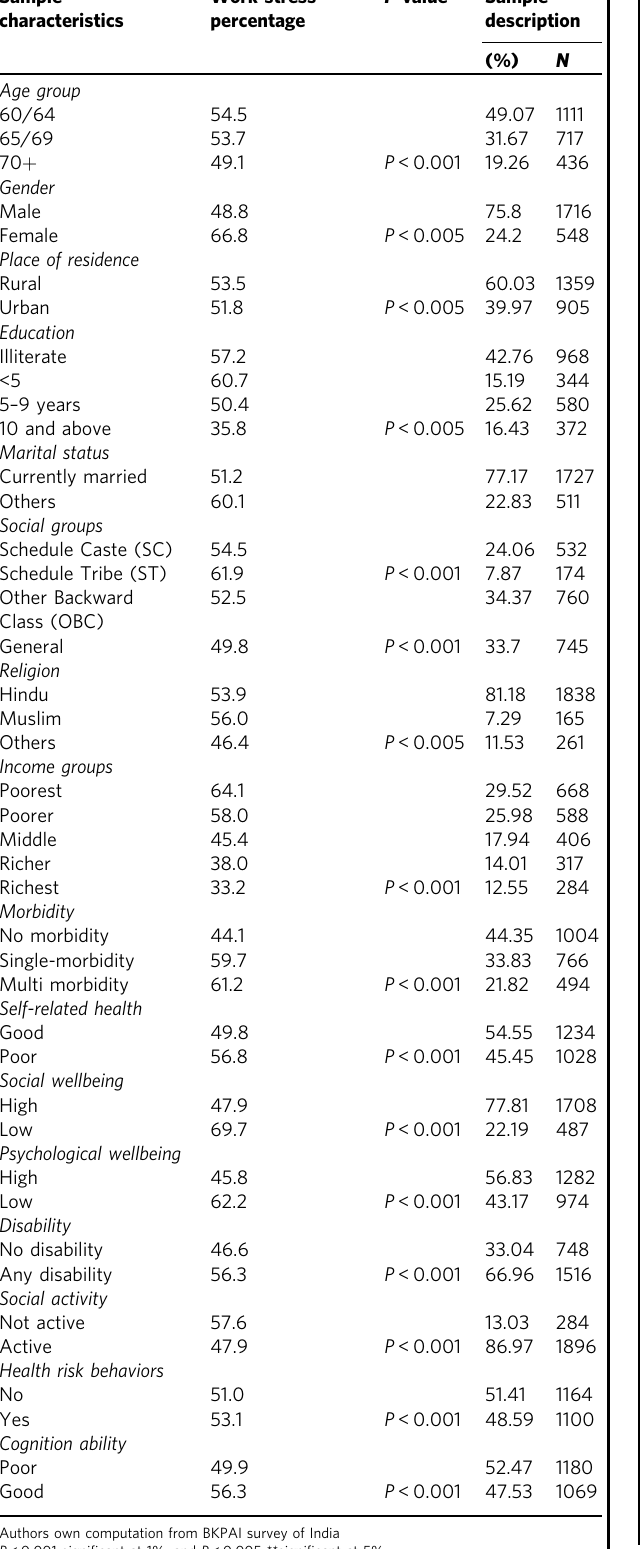
Table 1 Sample description and work stress prevalence by associated risk factors among older adults in India.